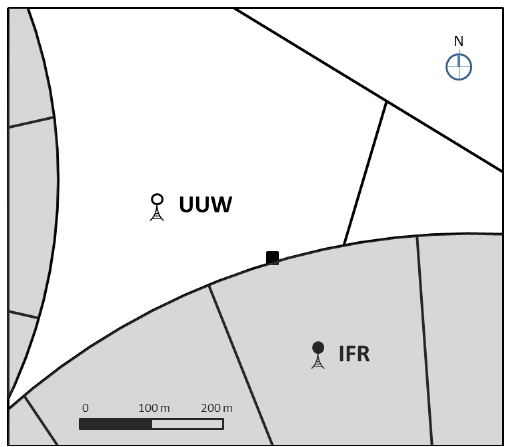
Figure 1. Schematic of the experimental area. The shaded areas rep- resent parts of pivot-irrigated intensively managed circles of dairy pasture. The white areas are not irrigated. At each of the labelled locations, UUW (unirrigated, unfertilised, winter-grazed) and IFR (irrigated, fertilised, rotationally grazed), CO 2 fluxes were mea- sured by eddy covariance, and air was sampled from two heights for multi-gas mole-fraction measurements with an FTIR spectrom- eter. The spectrometer was located in a temperature-controlled hut, indicated with a black